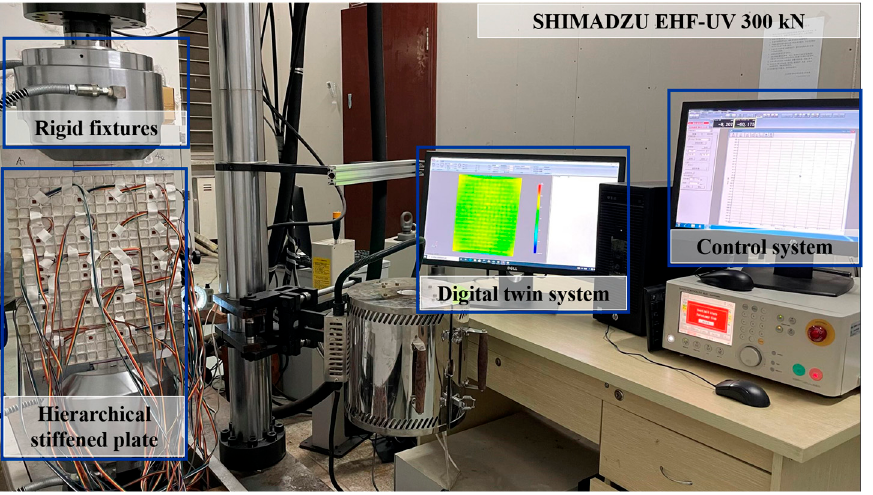
Figure 5. Static axial pressure digital twin experimental setup for the hierarchical stiffened plate.